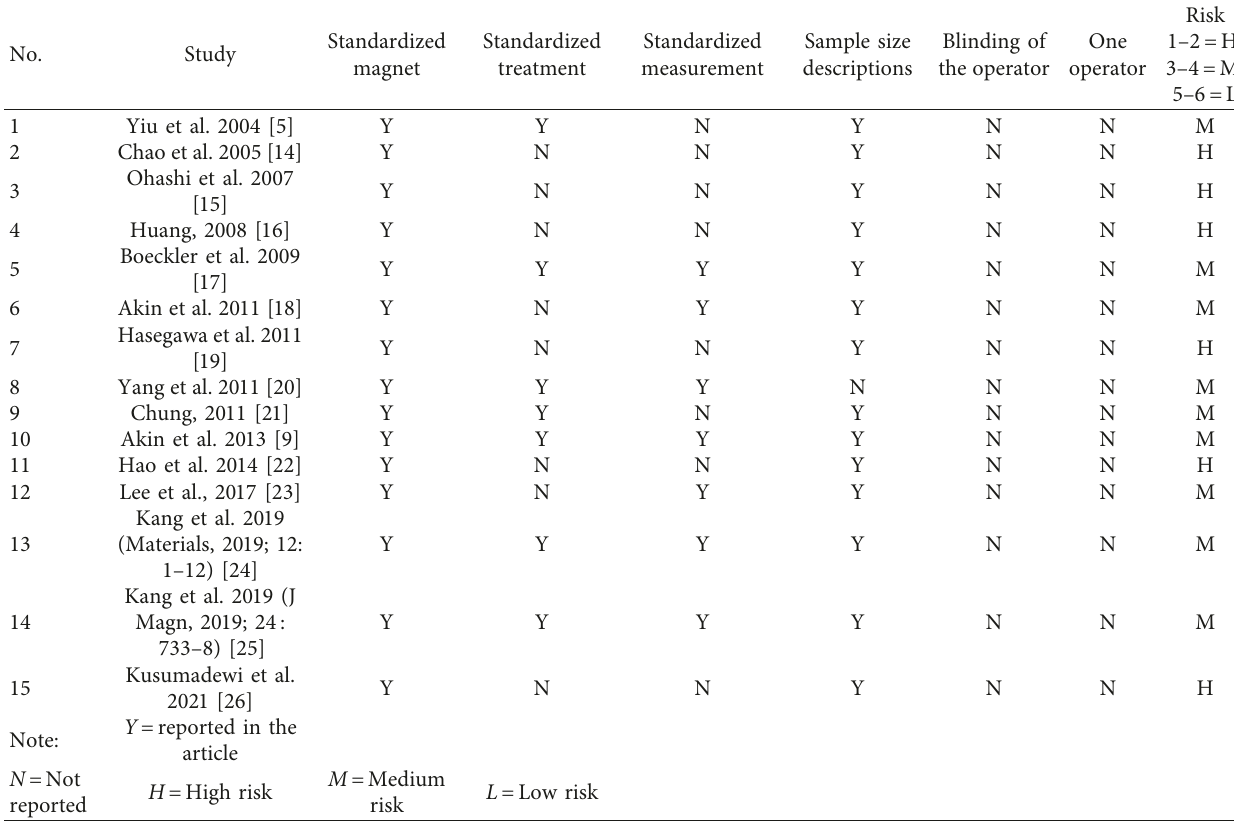
Table 3: Risk of bias considering parameters reported in reviewed